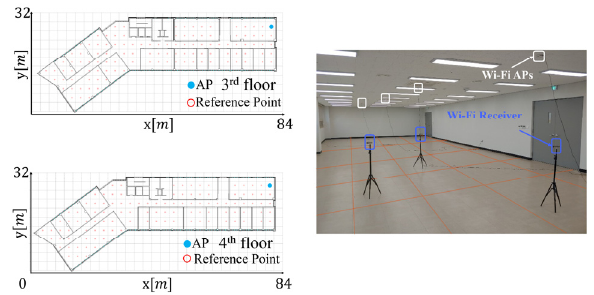
Figure 9. Experimental setup.